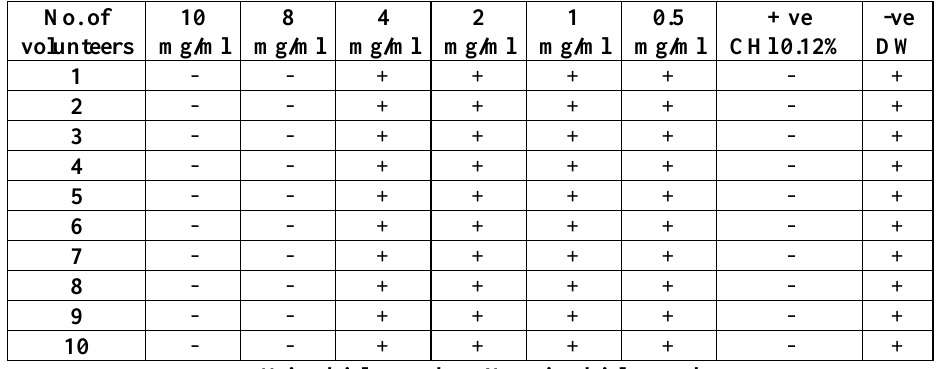
Table 2. Test Performance for Minimum Inhibitory Concentration (MIC) on Oral Lactobacilli No. of 10 8 4 2 1 0.5 + ve -ve volunteers mg/ml mg/ml mg/ml mg/ml mg/ml mg/ml CHl 0.12% DW 1 - - - + + + - + 2 - - - + + + - + 3 - - - + + + - + 4 - - - + + + - + 5 - - - + + + - + 6 - - + + + + - + 7 - - - + + + - + 8 - - - + + + - + 9 - - + + + + - + 10 - - + + + + - + +: Microbial growth, -: No microbial growth Table 3. Test Performance for Minimum Inhibitory Concentration (MIC) S. Aureus No. of 10 8 4 0.5 -ve volunteers mg/ml mg/ml mg/ml mg/ml mg/ml 1 - - + + + + - + 2 - - + + + + - + 3 - - - - - 5 - -